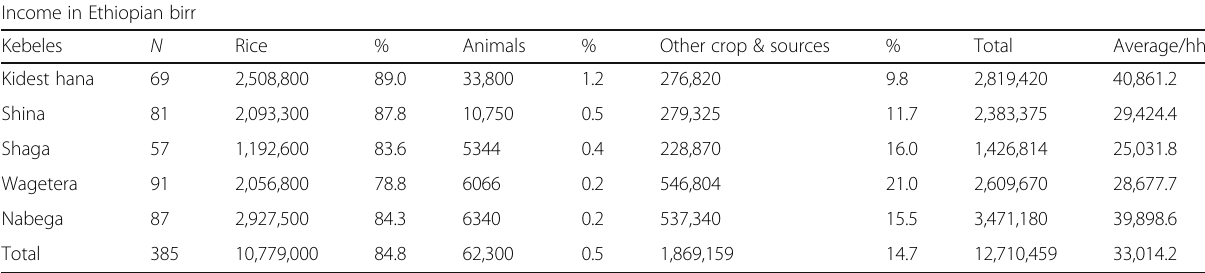
Table 4 Annual incomes of the sample household in the surveyed sample kebeles Income in Ethiopian birr